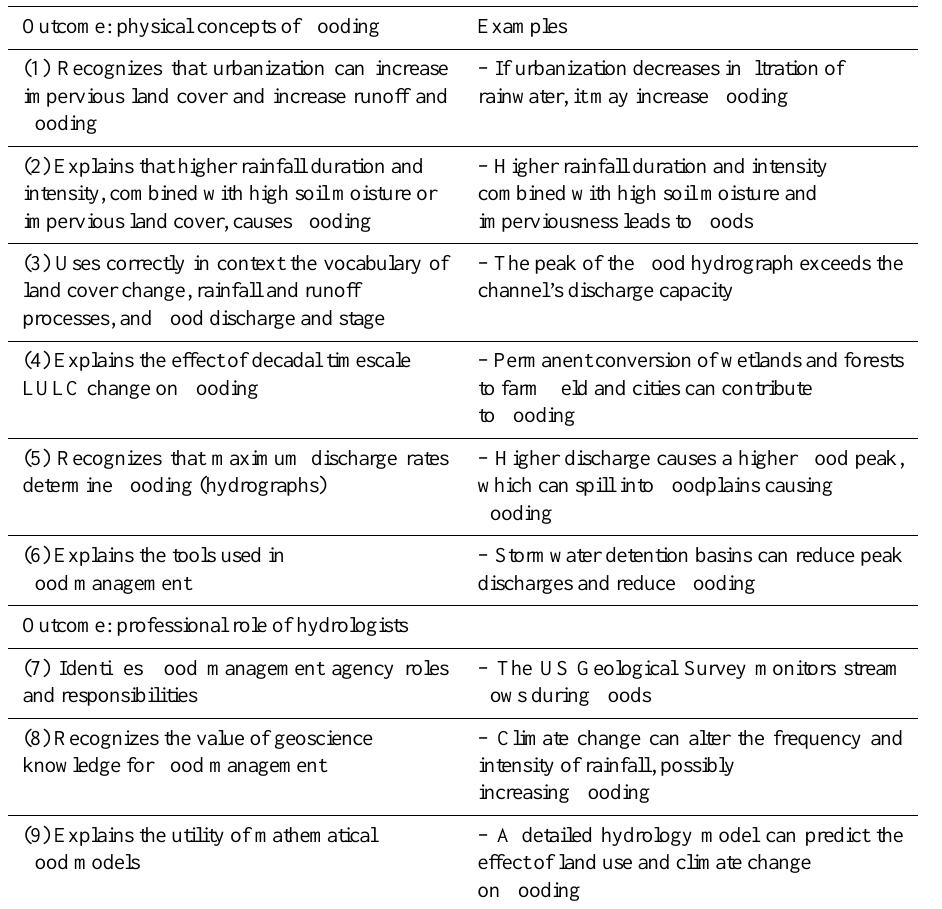
Table 2. Examples of conceptual mastery for each of nine